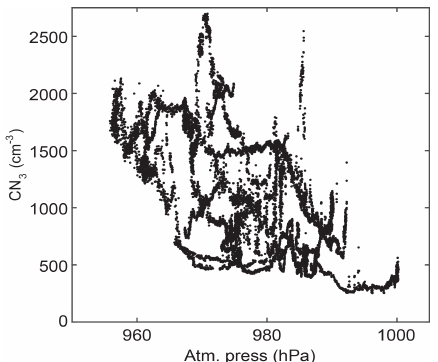
Figure 5. Measured atmospheric surface pressure (hPa) vs. CN 3 (cm − 3 ) for the period of 4–25 October (prior to this period, influ- ence came primarily from the northwest marine boundary layer). Short-term enhancement events on the 9 and 18 October are re-